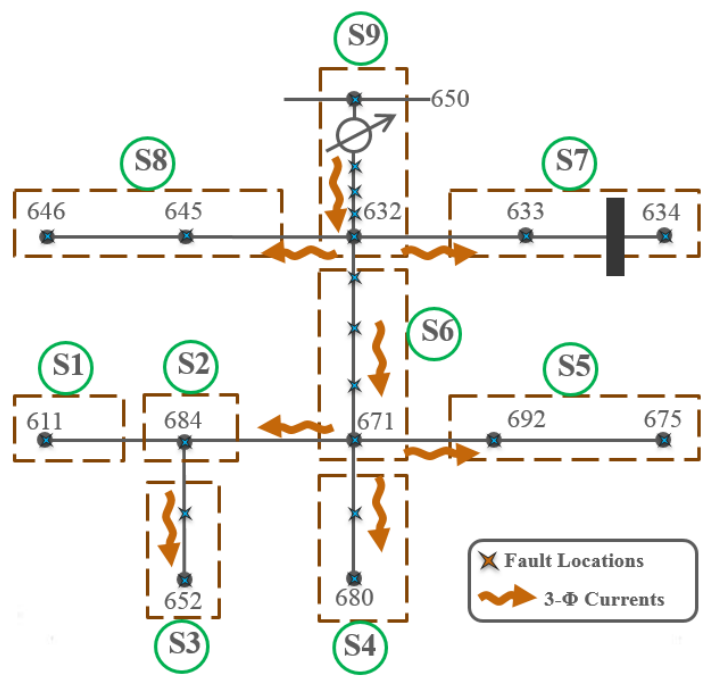
Figure 12. IEEE thirteen-node test distribution feeder.